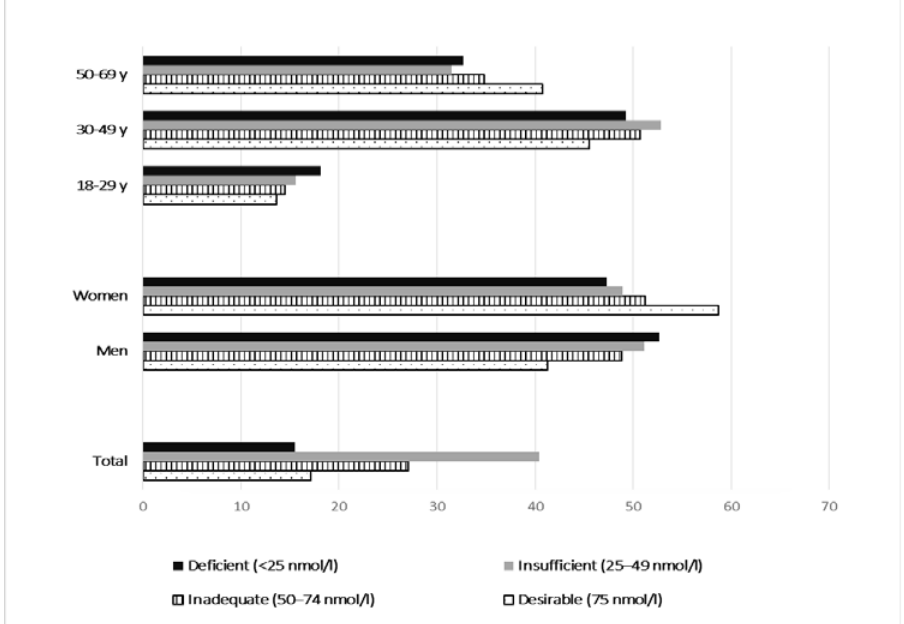
Figure 1. Total, sex- and age-specific prevalence of different categories of vitamin D, among the adults in Luxembourg, ORISCAV-LUX study.